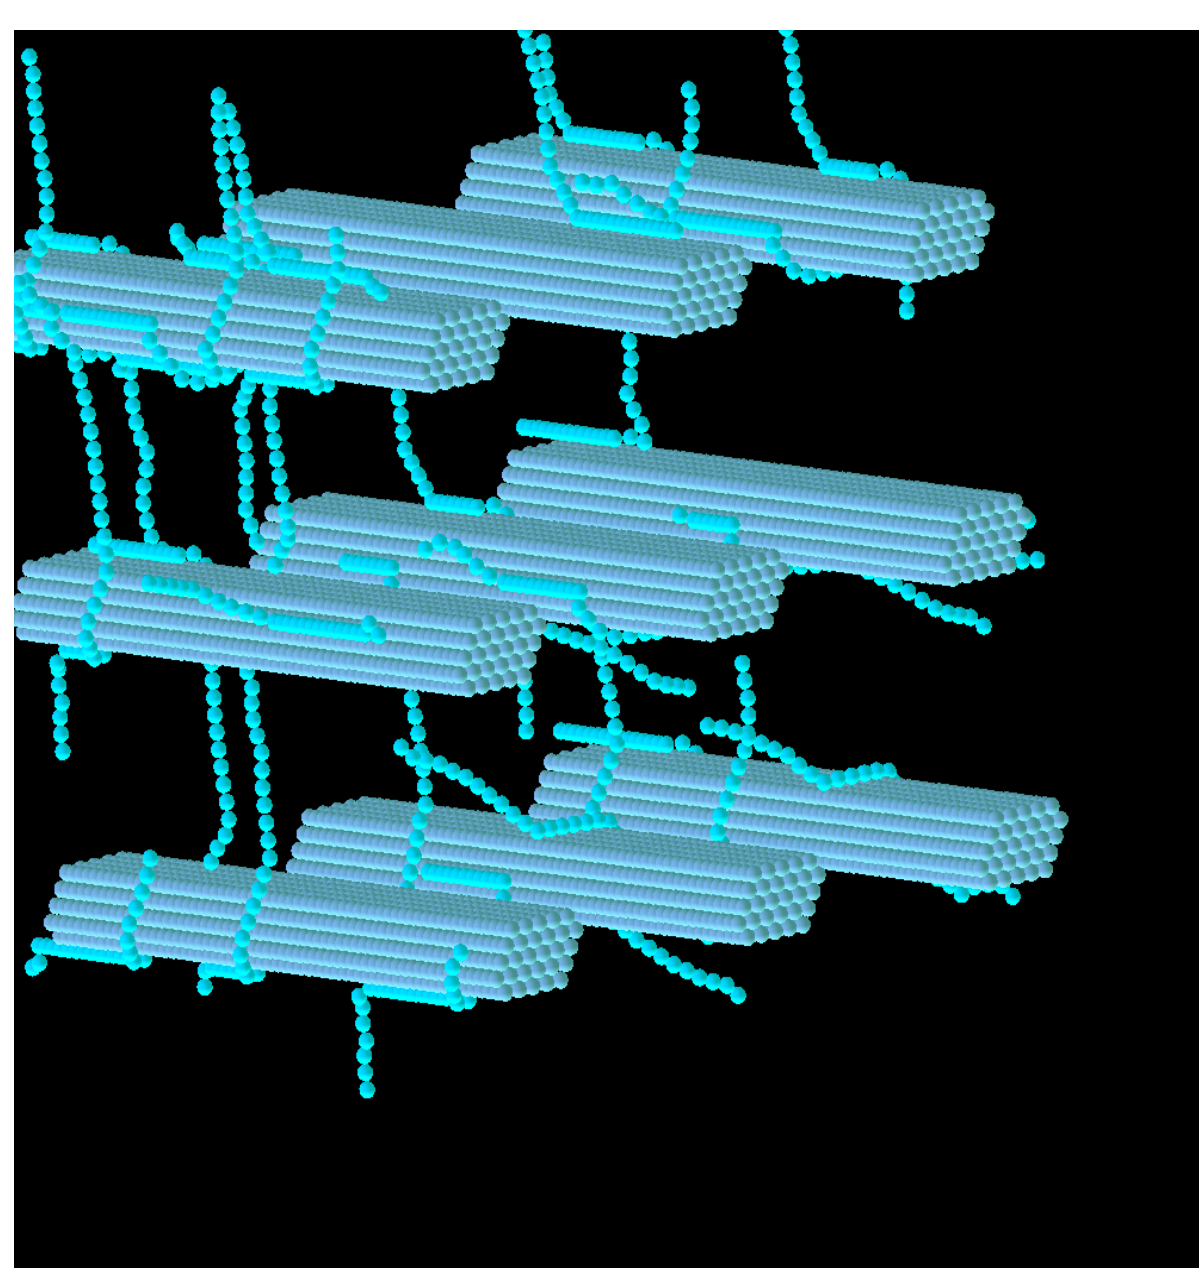
Figure 2. The first stage of constructing the simulated wall of a perennial ryegrass mesophyll cell involved the attachment of (1,3;1,4)- β -glucans to CMFs. Each blue sphere represents a glucose